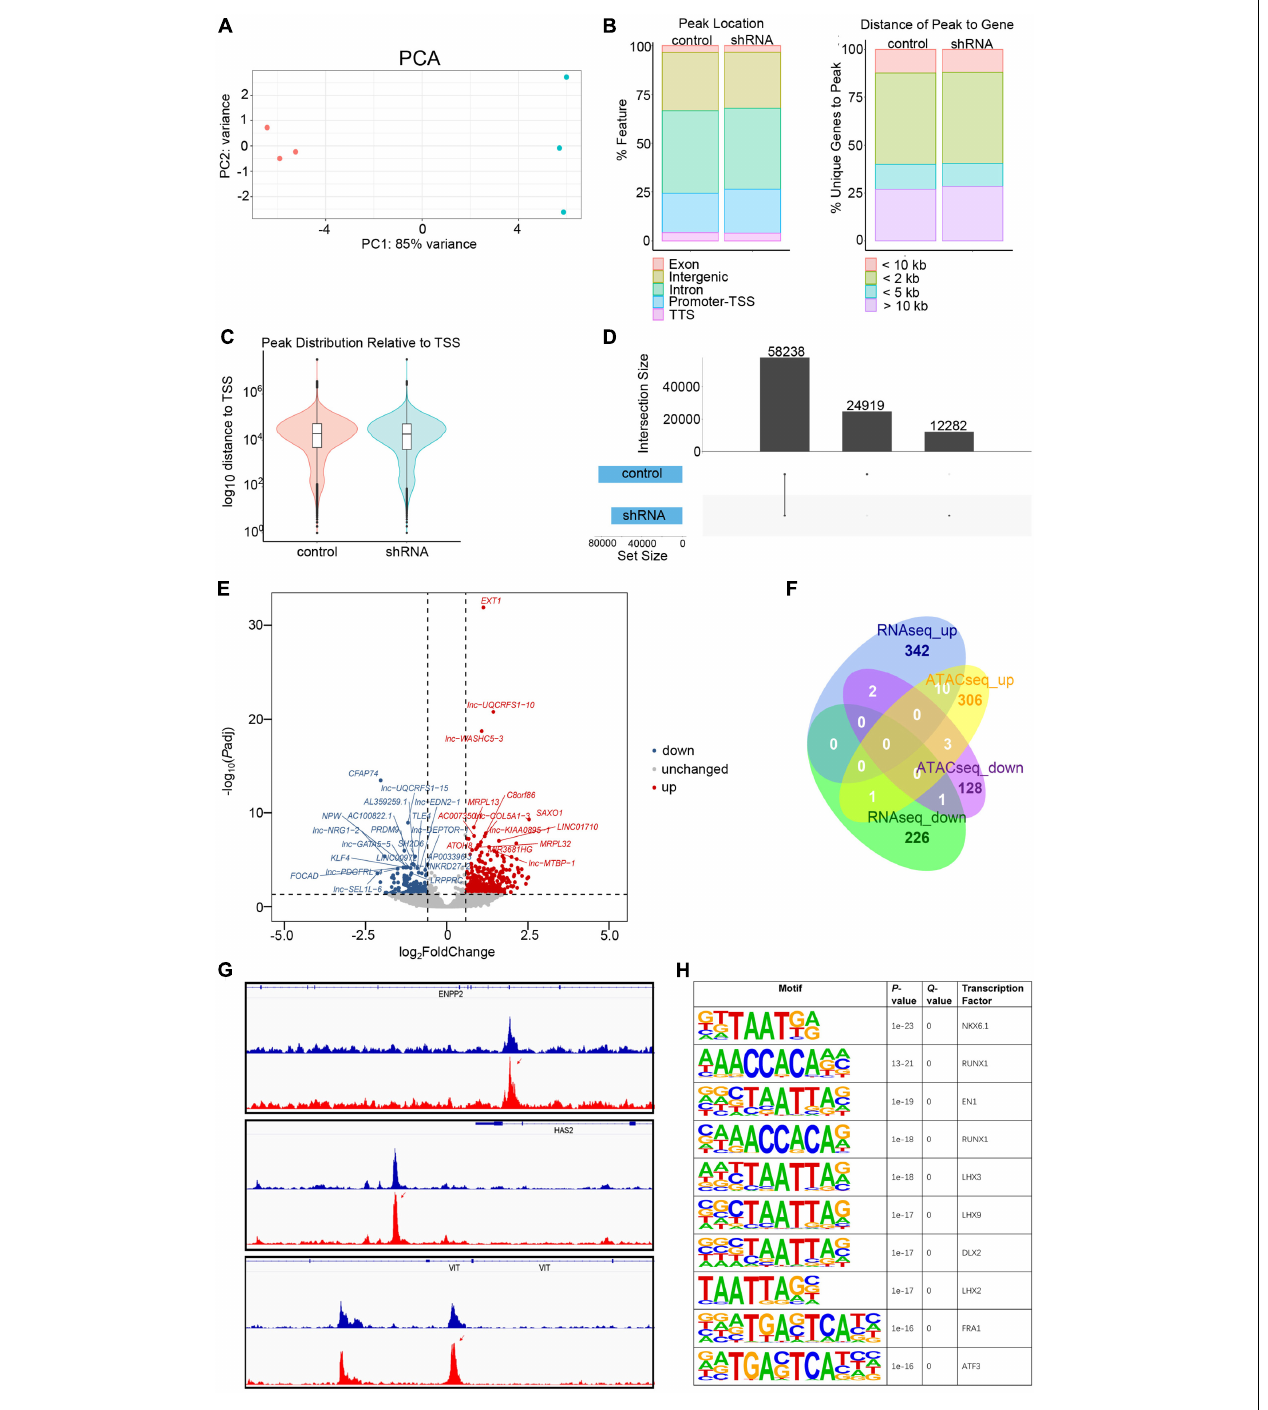
FIGURE 5 | Assay for transposase-accessible chromatin with sequencing (ATACseq) analysis of FGD5-AS1 knockdown (KD) CCC-HEH-2 cells. (A) Principal component analysis (PCA) plot of ATACseq. Control and shRNA KD CCC-HEH-2 cell samples are shown in red and cyan , respectively. (B) Peak location comparison of the gene features. (C) Distance of peaks relative to the closest gene. (D) Peak distribution relative to the transcriptional start site. (D) Consensus peak number comparison of control of the KD samples. (E) Volcano plot of differential accessible region analysis. The top 20 significantly up/downregulated regions are labeled as the closest gene symbol. (F) Venn plot of differential gene expression analysis and differential accessible region analysis based on gene annotation. (G) Peak comparison of the differential accessible regions identified in ENPP2 , HAS2 , and VIT . (H) Enriched known motifs of the transcription factors within the differential accessible region sequences. Only the top 10 significant motifs are